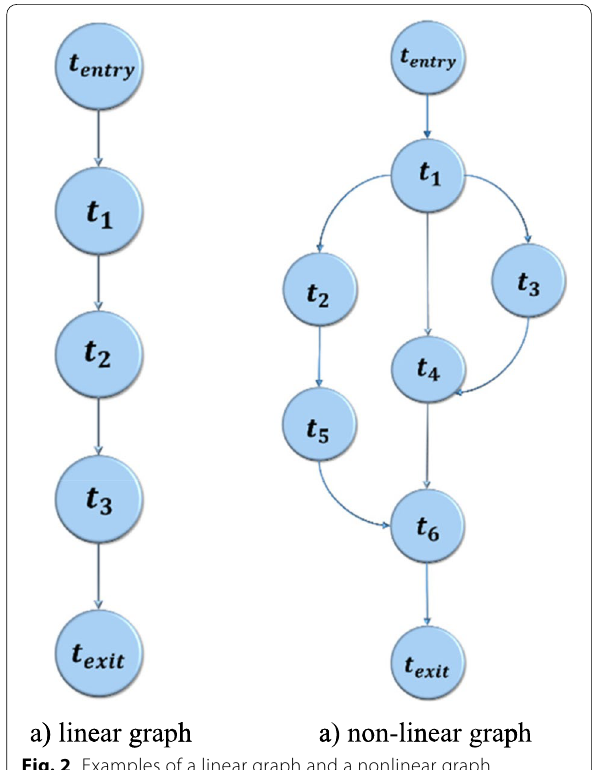
Fig. 2 Examples of a linear graph and a nonlinear